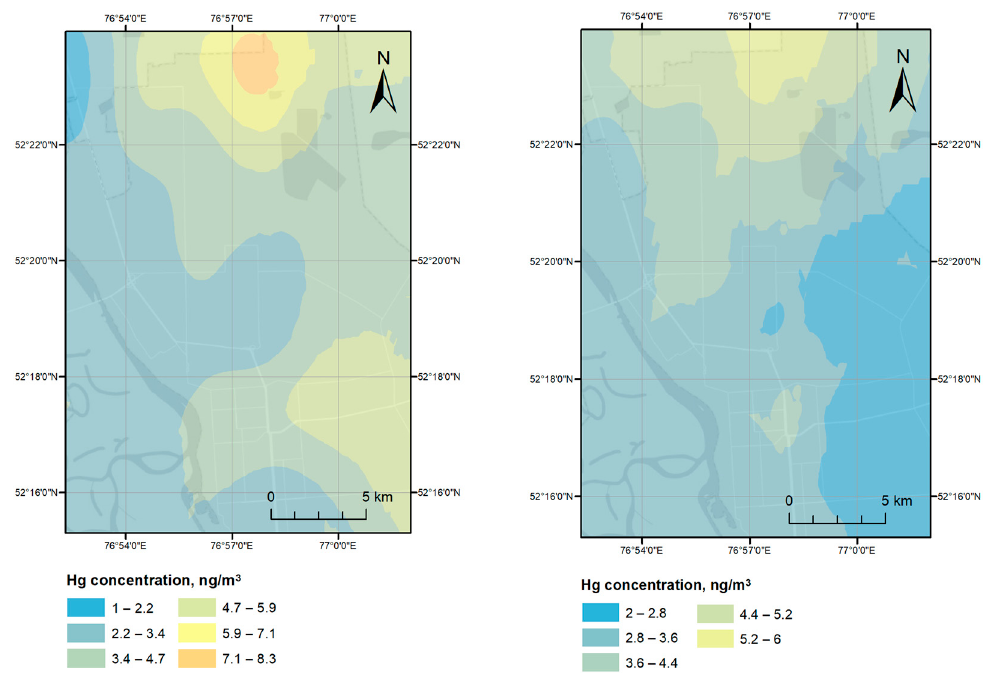
Figure 4. Atmospheric Hg dispersion over study area during Campaigns 3 and 4.